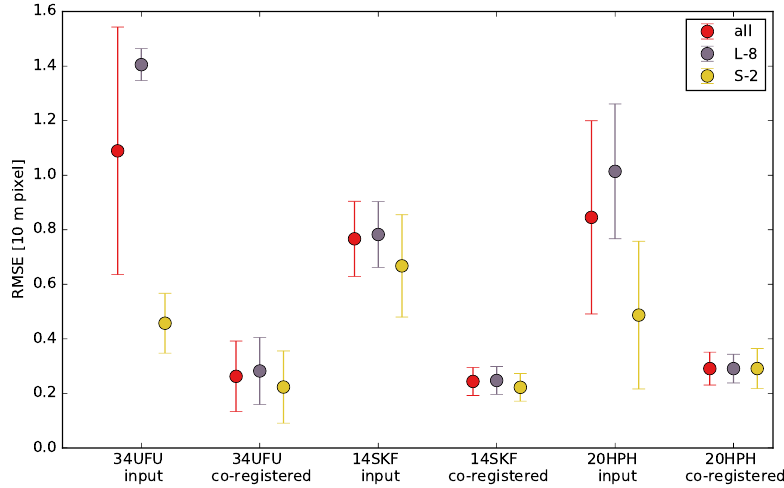
Figure 3. RMSEs before and after co-registration at three test sites in Ukraine (34UFU), USA (14SKF) and Argentina (20HPH). (note, L-8: Landsat-8; S-2: